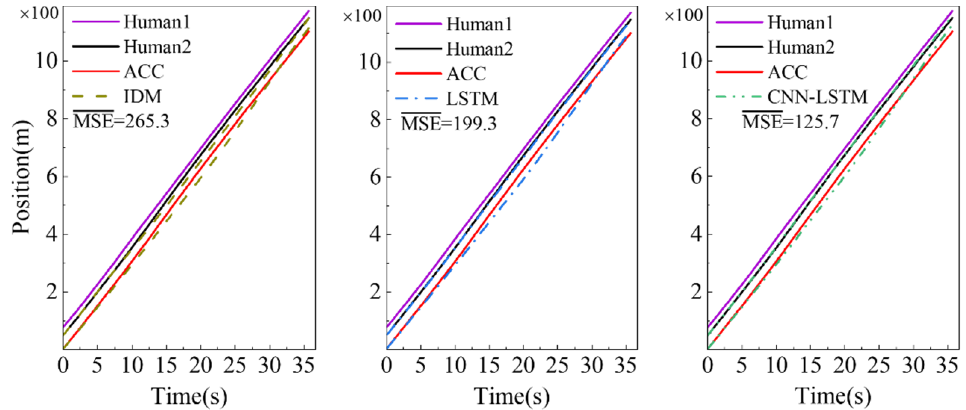
Figure 10. Platoon simulation in heterogeneous traffic flow mixed with ACC vehicles.